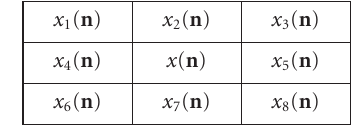
Figure 1: 3 × 3 window.